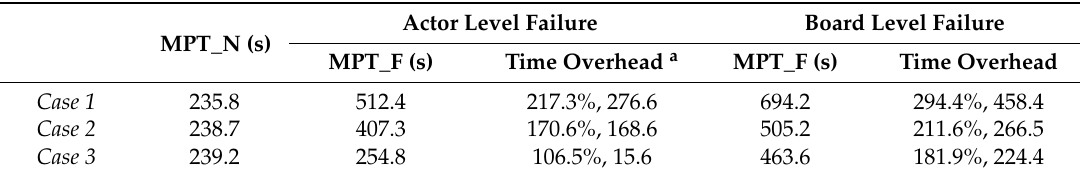
Table 6. The mean process time and overhead of the three